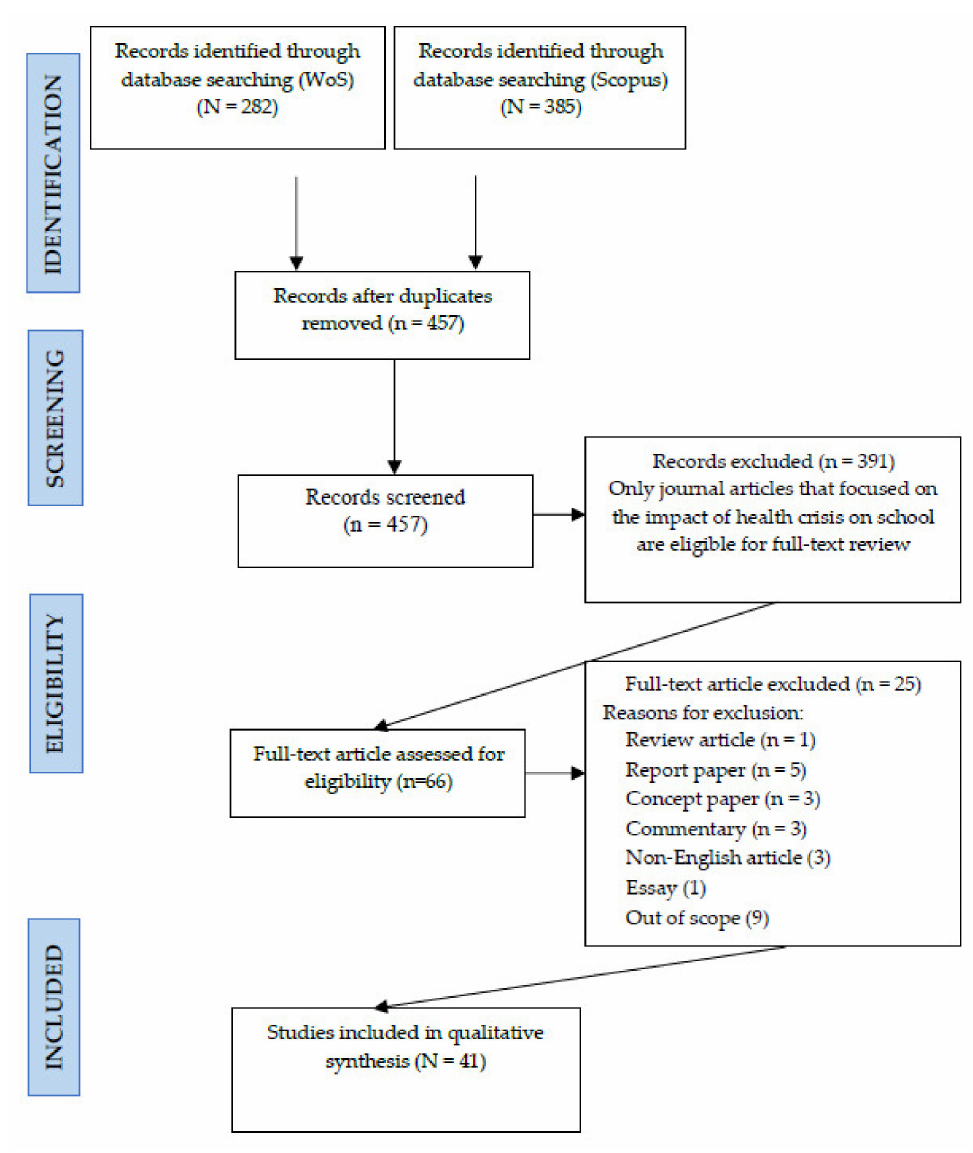
Figure 1. PRISMA flow diagram of the